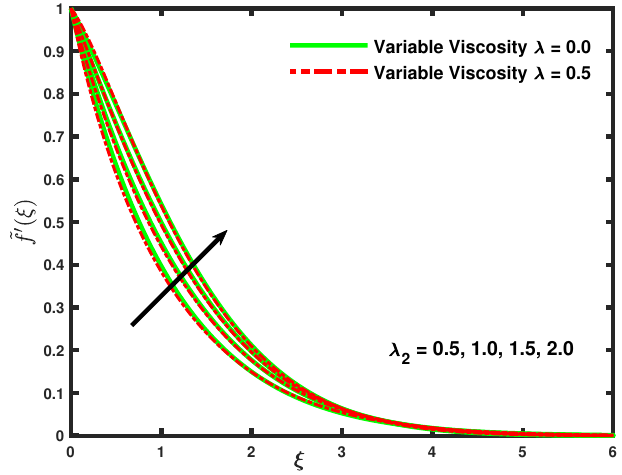
Figure 13. The influence of the Buoyancy parameter ( λ 2 ) on the Velocity